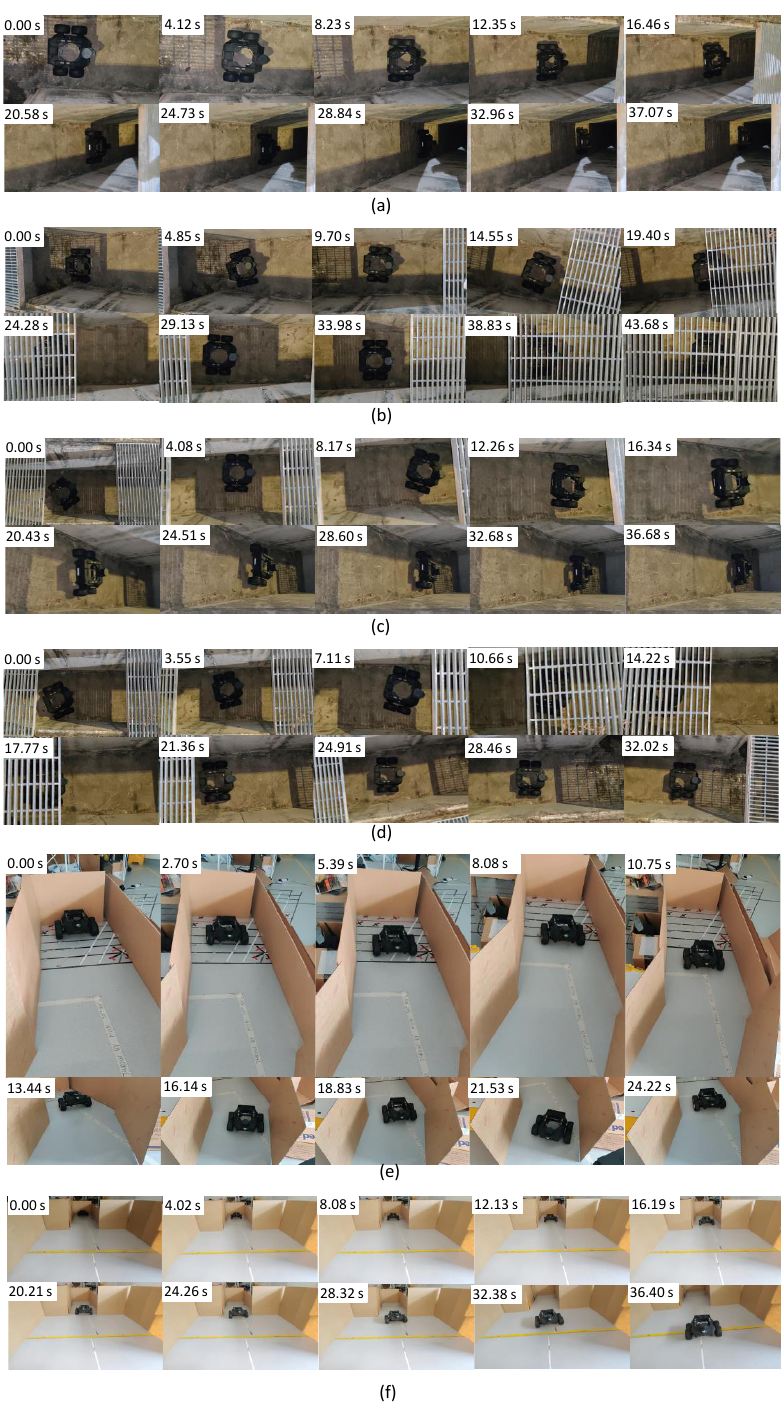
Figure 12. Arrangement of the test scenarios and the sequence of the robot’s movement. ( a ):